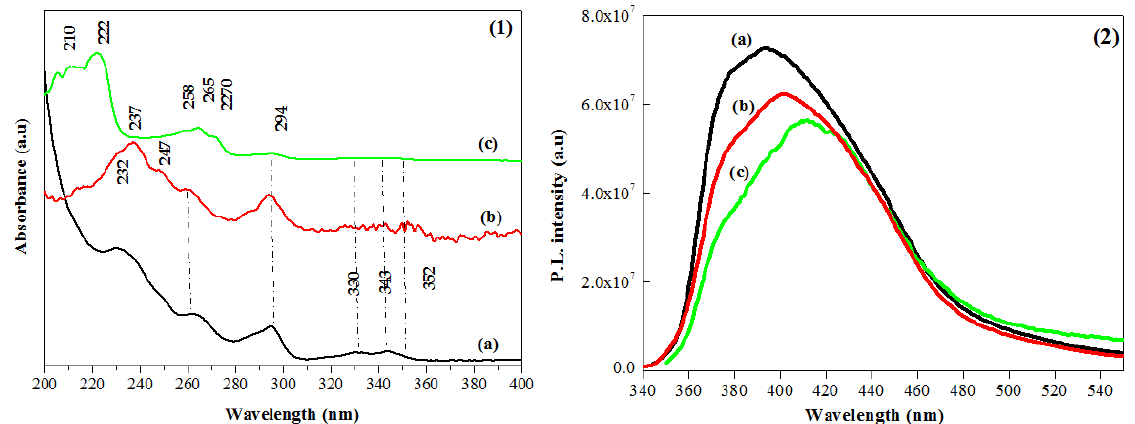
Figure 4. Changes in OA ( 1 ) and PL ( 2 ) spectra. Before SWCNT addition ( a ) and after SWCNT addition in chloroform ( b ) and in chlorobenzene ( c ).